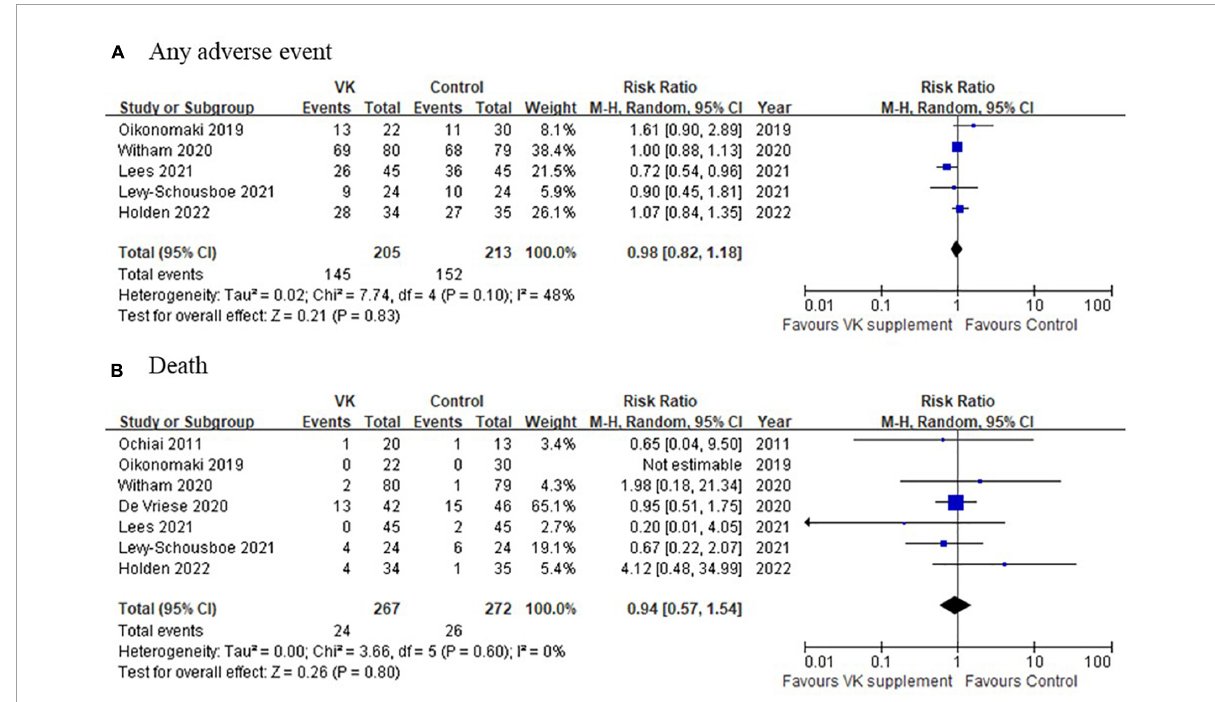
FIGURE6 A comparison of adverse events between Vitamin K supplementation and control groups. (A) Any adverse event and (B) death between Vitamin K supplementation and control